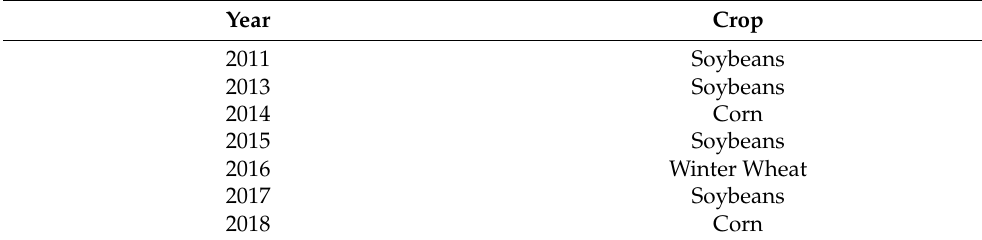
Table 1. Crop types included in this study.